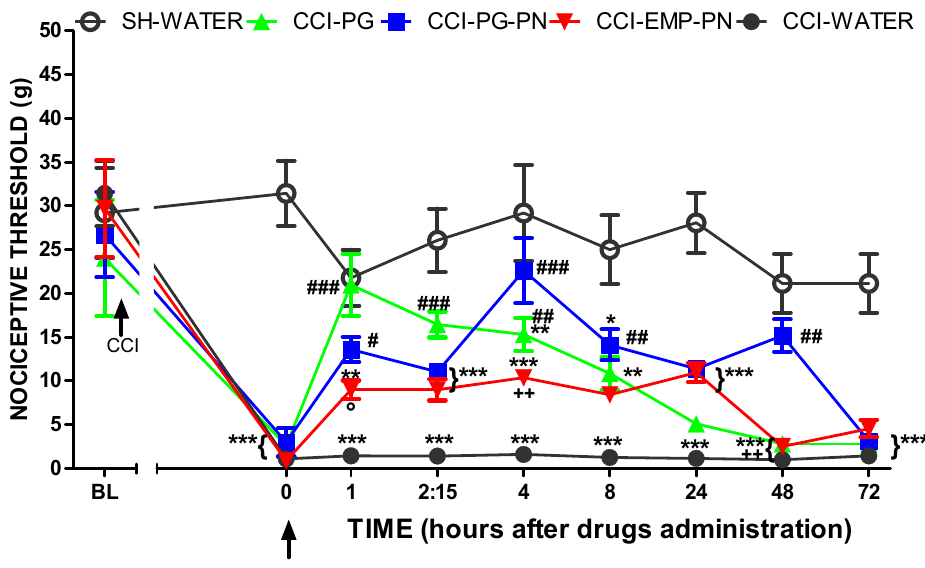
Figure 11. The antinociceptive impact of the drugs—operated animals and sham—compared 72 h after treatment. Legend: Pregabalin: PG (10 mg/kg, Orally); WATER: vehicle of PG; PN: polymeric nanocomposite; PG-PN: PG-loaded polymeric nanocomposite (10 mg PG/kg, Orally); EMP-PN: polymeric nanocomposite without PG (vehicle of PG-PN); CCI: chronic sciatic nerve constriction injury; SH: sham; BL: baseline latency; 0: on 14th day after CCI, immediately before administration of the substances; experimental time: 72 h after administration of the substances. Two-way ANOVA test with repeated measures with Bonferroni post-test was applied for the comparison between the different groups, * p < 0.05; ** p < 0.01; *** p < 0.001 when compared with the SH-WATER group, ## p < 0.01; ### p < 0.001 when compared with the CCI-WATER group; ++ p < 0.01 when compared with the CCI-PG-PN group; ° p < 0.05 when compared with the CCI-PG group. Each point represents the mean ± standard error of the mean (±S.E.M.) of six animals.